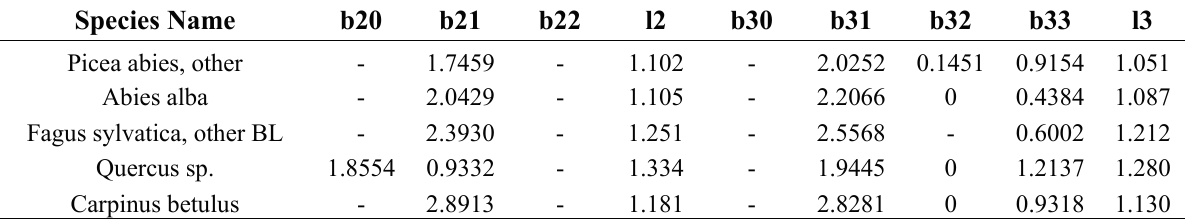
Table A4. Coefficients used in models for biomass in branches